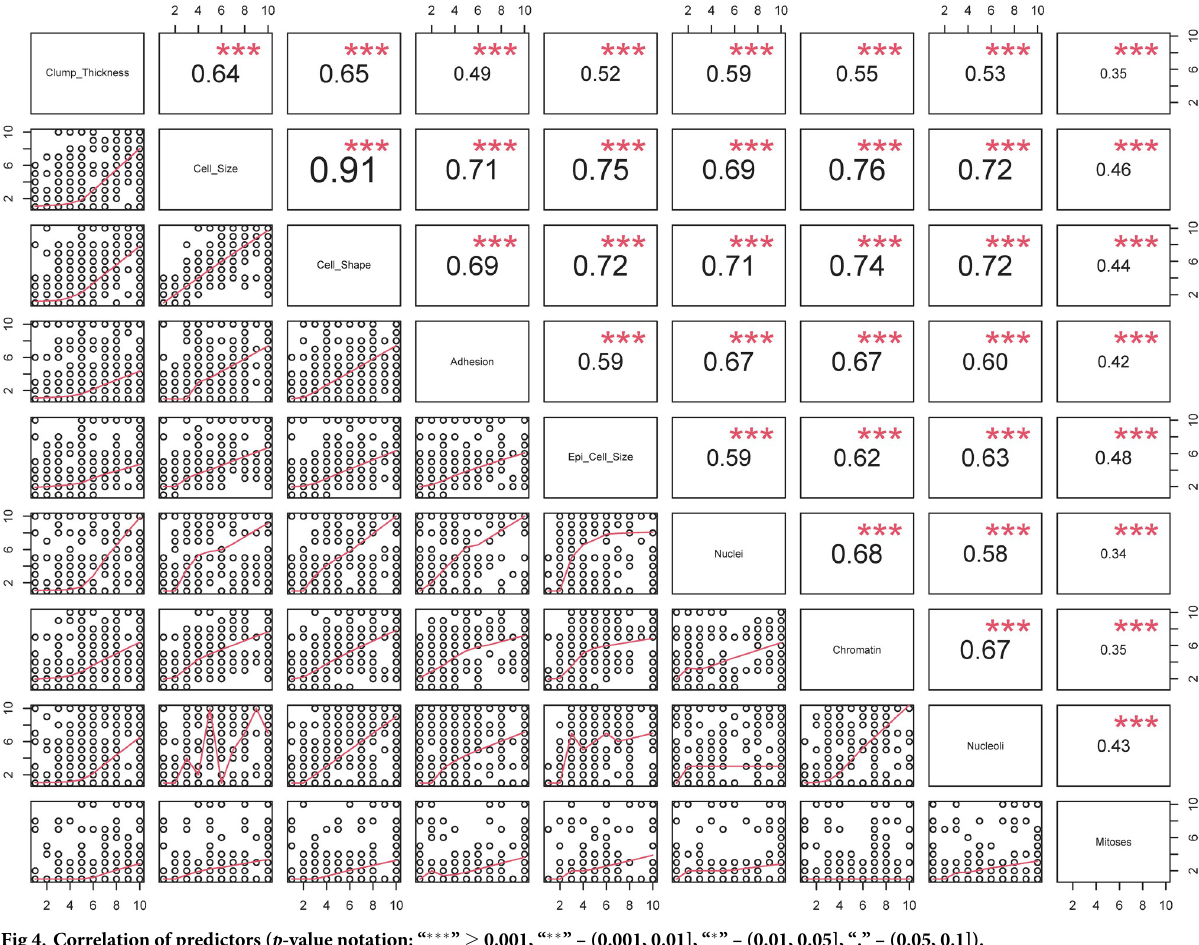
PLOS ONE | https://doi.org/10.1371/journal.pone.0269135 May 27,